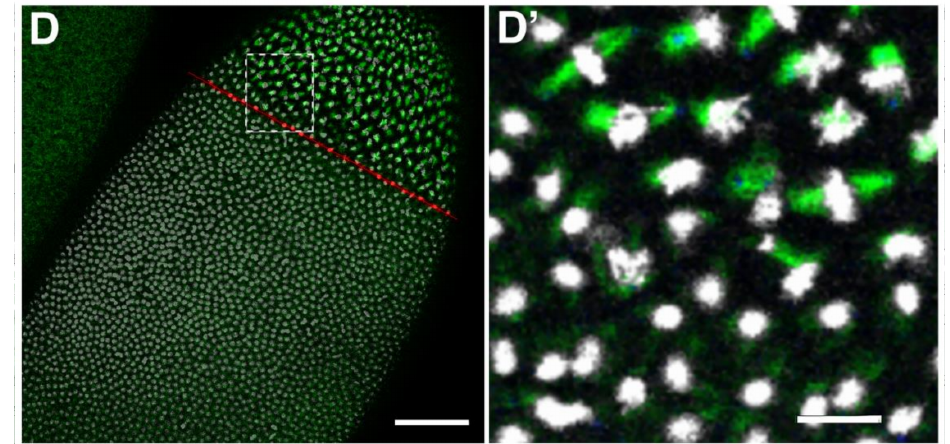
Figure 4. Expressivity of syncytial cleavage defects in spindly [ nos >RNAi] embryos. ( A ) spindly [ nos >RNAi] embryos raised at 21 ◦ C displayed a range of mitotic defects of the following classes ( n = 50): (a) normal development; (b) abnormal mitotic figures, examples in ( B ); (c) centrosome abnormalities (detachment, monopolar spindles, centrosome clustering; examples in ( C )); (d) uneven spacing of the mitotic domains and asynchrony of nuclear divisions (examples in ( D )); (e) dead embryos at later stages; ( B ) Abnormal mitotic figures; irregular spacing between adjacent mitotic domains. Details are shown from the dashed yellow boxes in merged panel. ( B1 ) Mitotic spindles collapse and fuse; ( B2 ) abnormal tubulin-rich structures associated with chromatin; ( B3 ) tri-polar spindle (Scale bars represent 50 µ m ( B ) and 5 µ m ( B1 – B3 ); ( C ) Centrosome abnormalities: Defects in cohesion between centrosomes and spindle poles. Details from merged panel marked with a dashed yellow box: ( C1 ) a pair of centrosomes associated to a single spindle pole (marked by arrowhead); ( C2 , C3 ) centrosomes detach from one ( C2 ) or both poles ( C3 ); arrowheads point to detaching centrosomes. Scale bar represents 50 µ m ( C ) and 5 µ m ( C1 – C3 ); ( D ) embryo with domains of distinct mitotic rate; red line marks boundary between a region of interphase nuclei and a region with mitotic divisions. ( D’ ) higher magnification of boxed area in ( D ). Scale bars represent 50 µ m ( D ) and 10 µ m ( D’